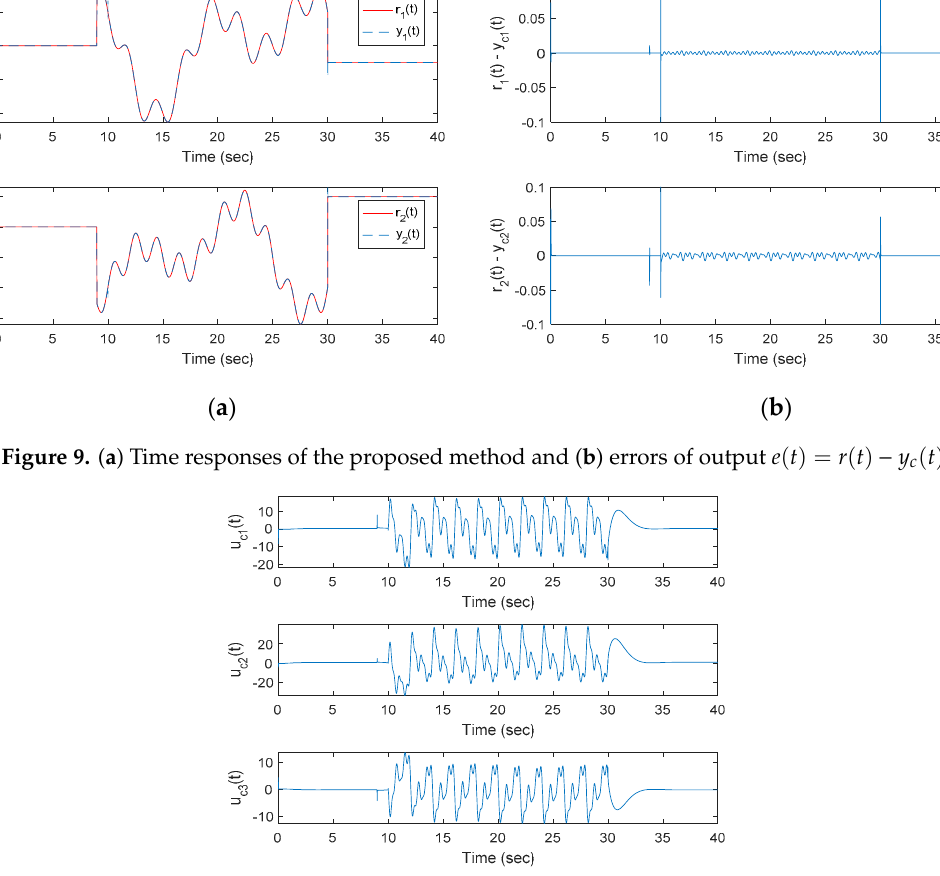
Figure 10. Control inputs for the OKID-based LQAT tracker with the proposed EID compensation for the non-square system with mismatched input and output disturbances.